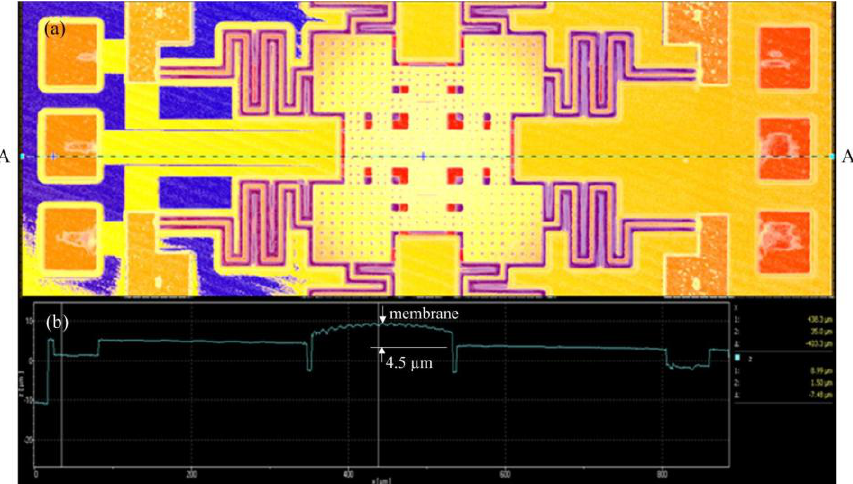
Figure 10. RF switch without annealing: ( a ) top view image; ( b ) profile along AA